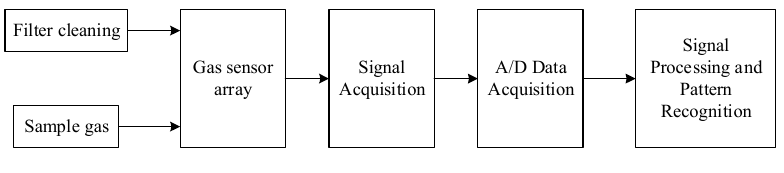
Figure 1. Structure diagram of E-nose system.